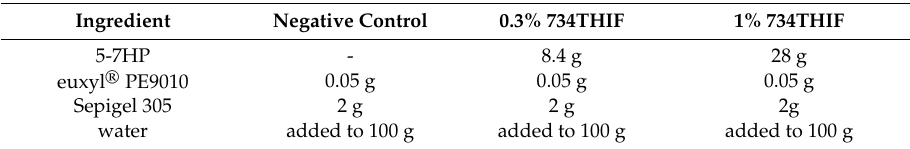
Table 2. Composition of 5-7HP